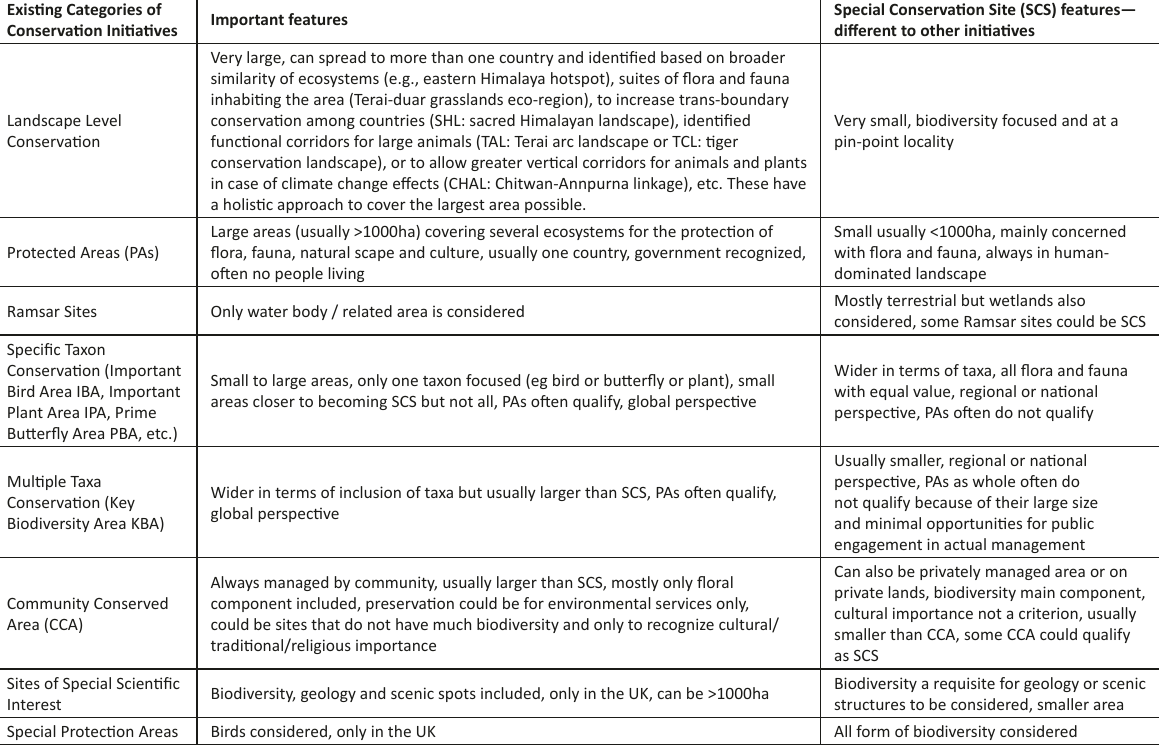
Table 1. SCS and other conservation initiatives in the region with their main features Existing Categories of Conservation